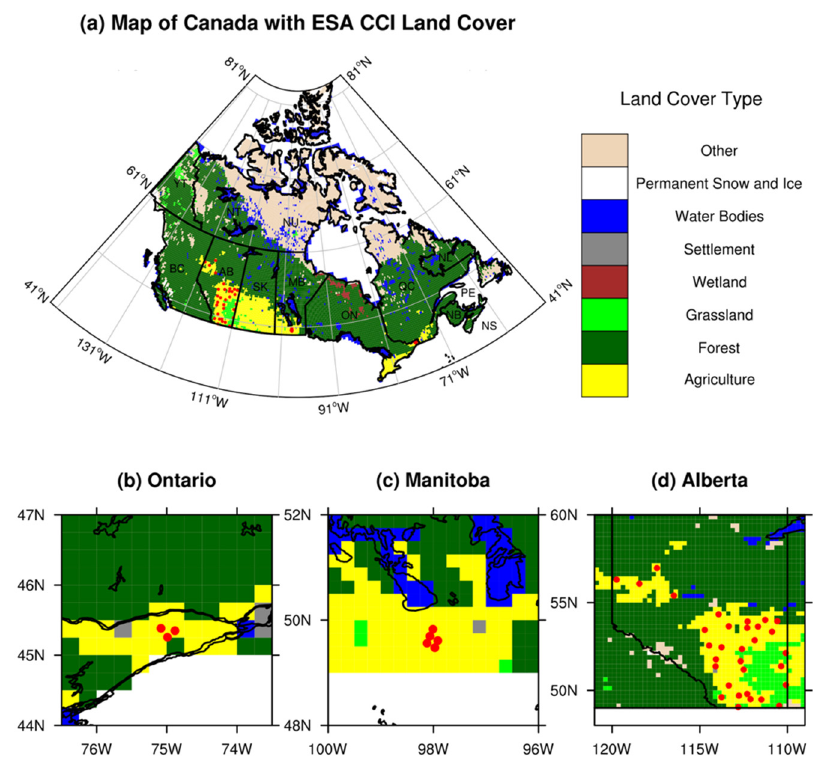
Figure 1. Location of in situ soil moisture monitoring sites in agricultural regions of Canada used in this study. ( a ) Map of Canada and zoomed in regions of ( b ) Ontario, ( c ) Manitoba and ( d ) Alberta showing the location of monitoring stations. In situ monitoring station locations are represented by red dots. Some stations are shown to overlap each other in ( b ) and ( c ) due to their close proximity. The land cover types, shown at 0.25 ◦ , are obtained from the most recent ESA CCI Land Cover map [48] and are grouped based on the IPCC land categories [48].